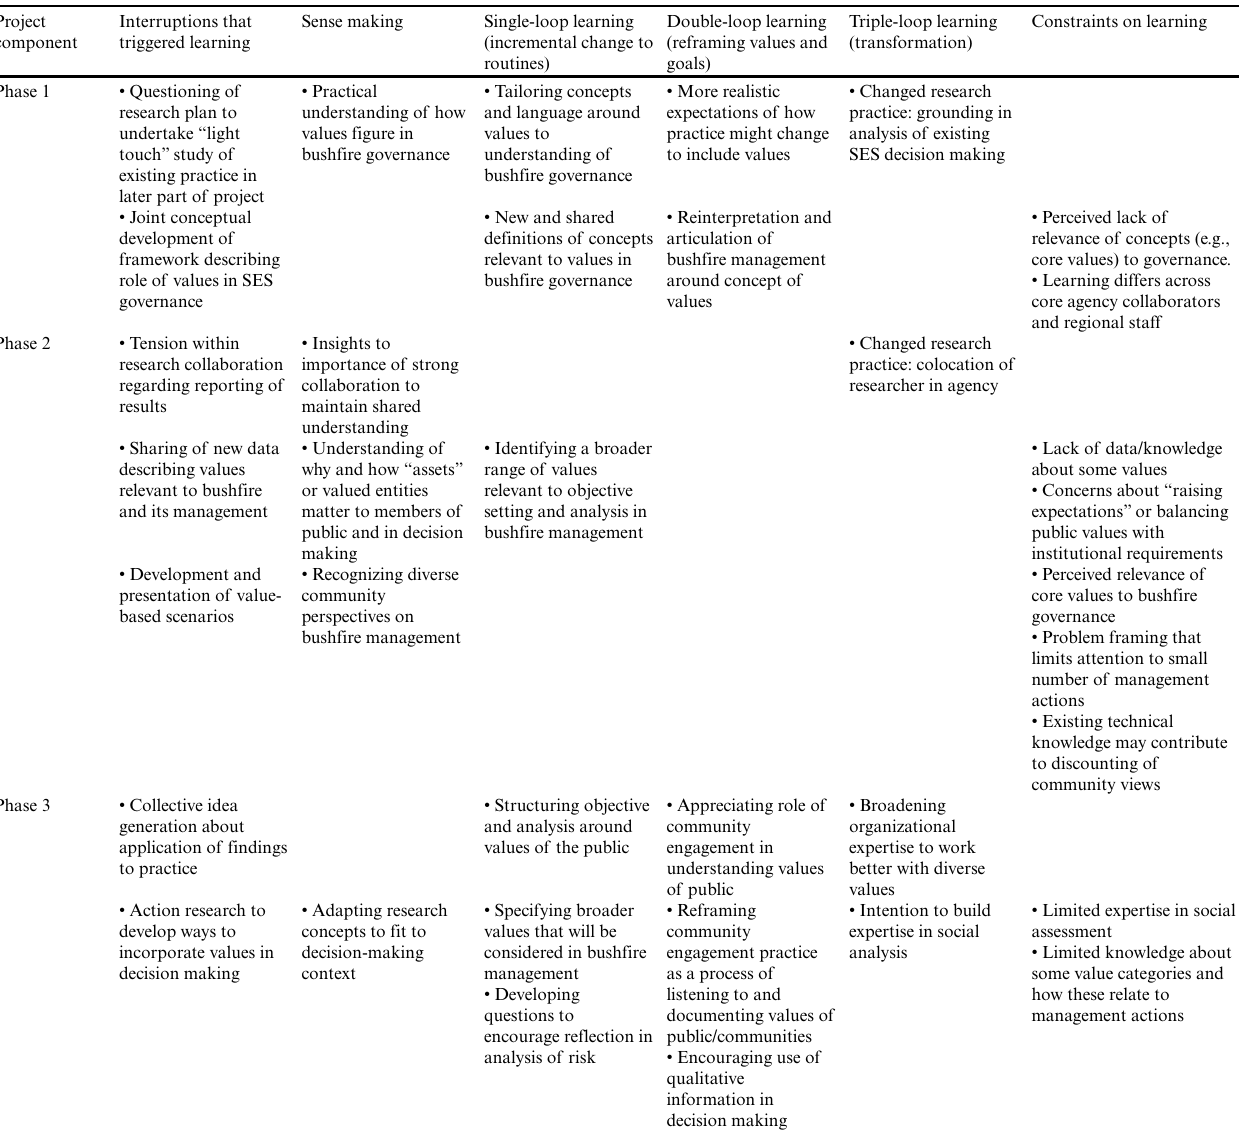
Table 1. Examples of how a 3-year collaborative research program supported social learning about incorporating values in bushfire